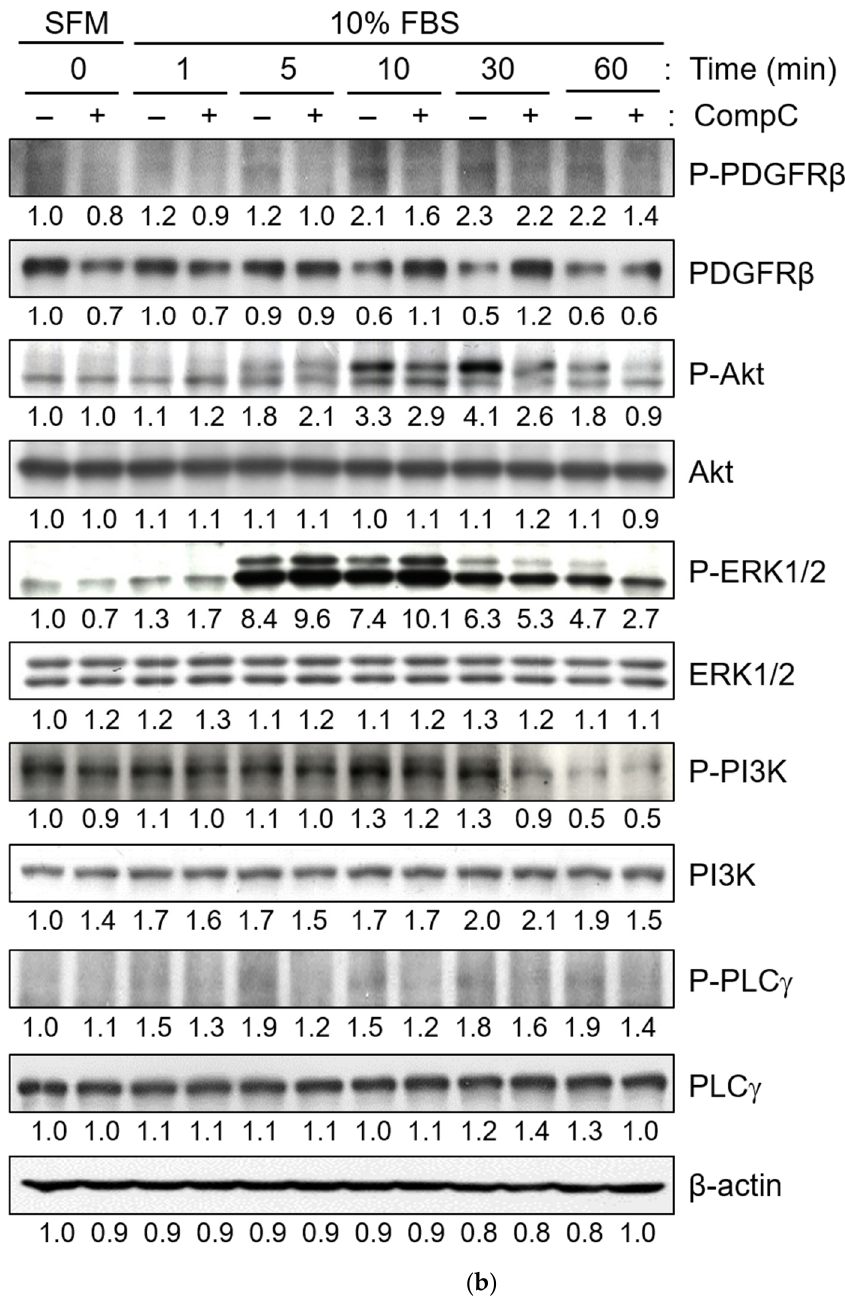
Figure 3. CompC reduced platelet-derived growth factor (PDGF) and serum (FBS)-induced activa- tion/phosphorylation of PDGF receptor (PDGFR) as well as the downstream signaling proteins. Renca cells were cultured for one day and then serum-starved by incubation with SFM overnight. Cells were pre-treated with the vehicle ( − ) or 10 μ M CompC for 1 h and then treated with a medium containing PDGF ( a ) or 10% FBS ( b ) for the indicated times. The cells were lysed, and the total cell extract (30 μ g per lane) was examined by western blot analysis using antibodies against phospho- PDGFR β (P-PDGFR β ), PDGFR β , P-Akt, Akt, P-ERK1/2, ERK1/2, P-PI3K, PI3K, P-PLC γ , and PLC γ , with β -actin as internal control. The band densities were normalized against β -actin and the fold changes compared to that of control (SFM/0 min/ − CompC) are written under each band. ROS have been shown to play a role in ERK activation [15,26]. ROS-induced ERK activation has also been implicated in cell cycle arrest [27,28]. Therefore, to confirm that CompC-induced ERK1/2 activation might be due to ROS production in Renca cells, we measured the ROS levels in vehicle- or CompC-treated cells. The level of intracellular ROS